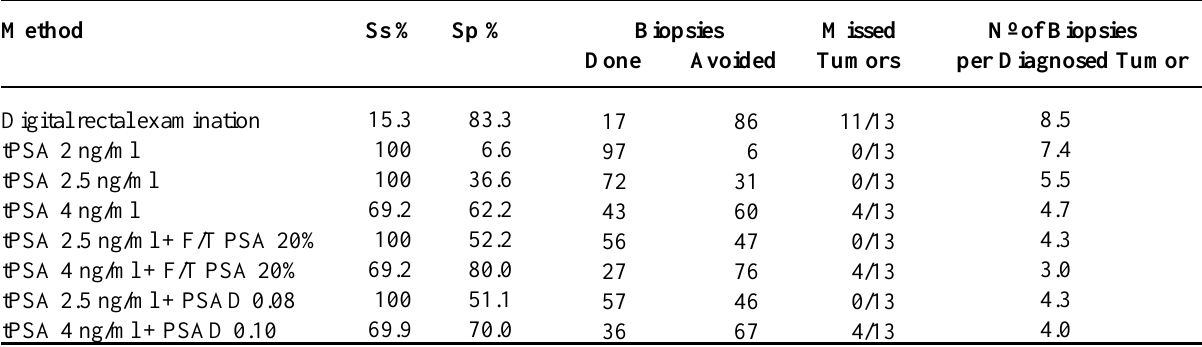
Table 3 - Some performance parameters of methods for indication of prostate biopsies, alone or associated, for the volunteers set with total PSA from 0 to 10